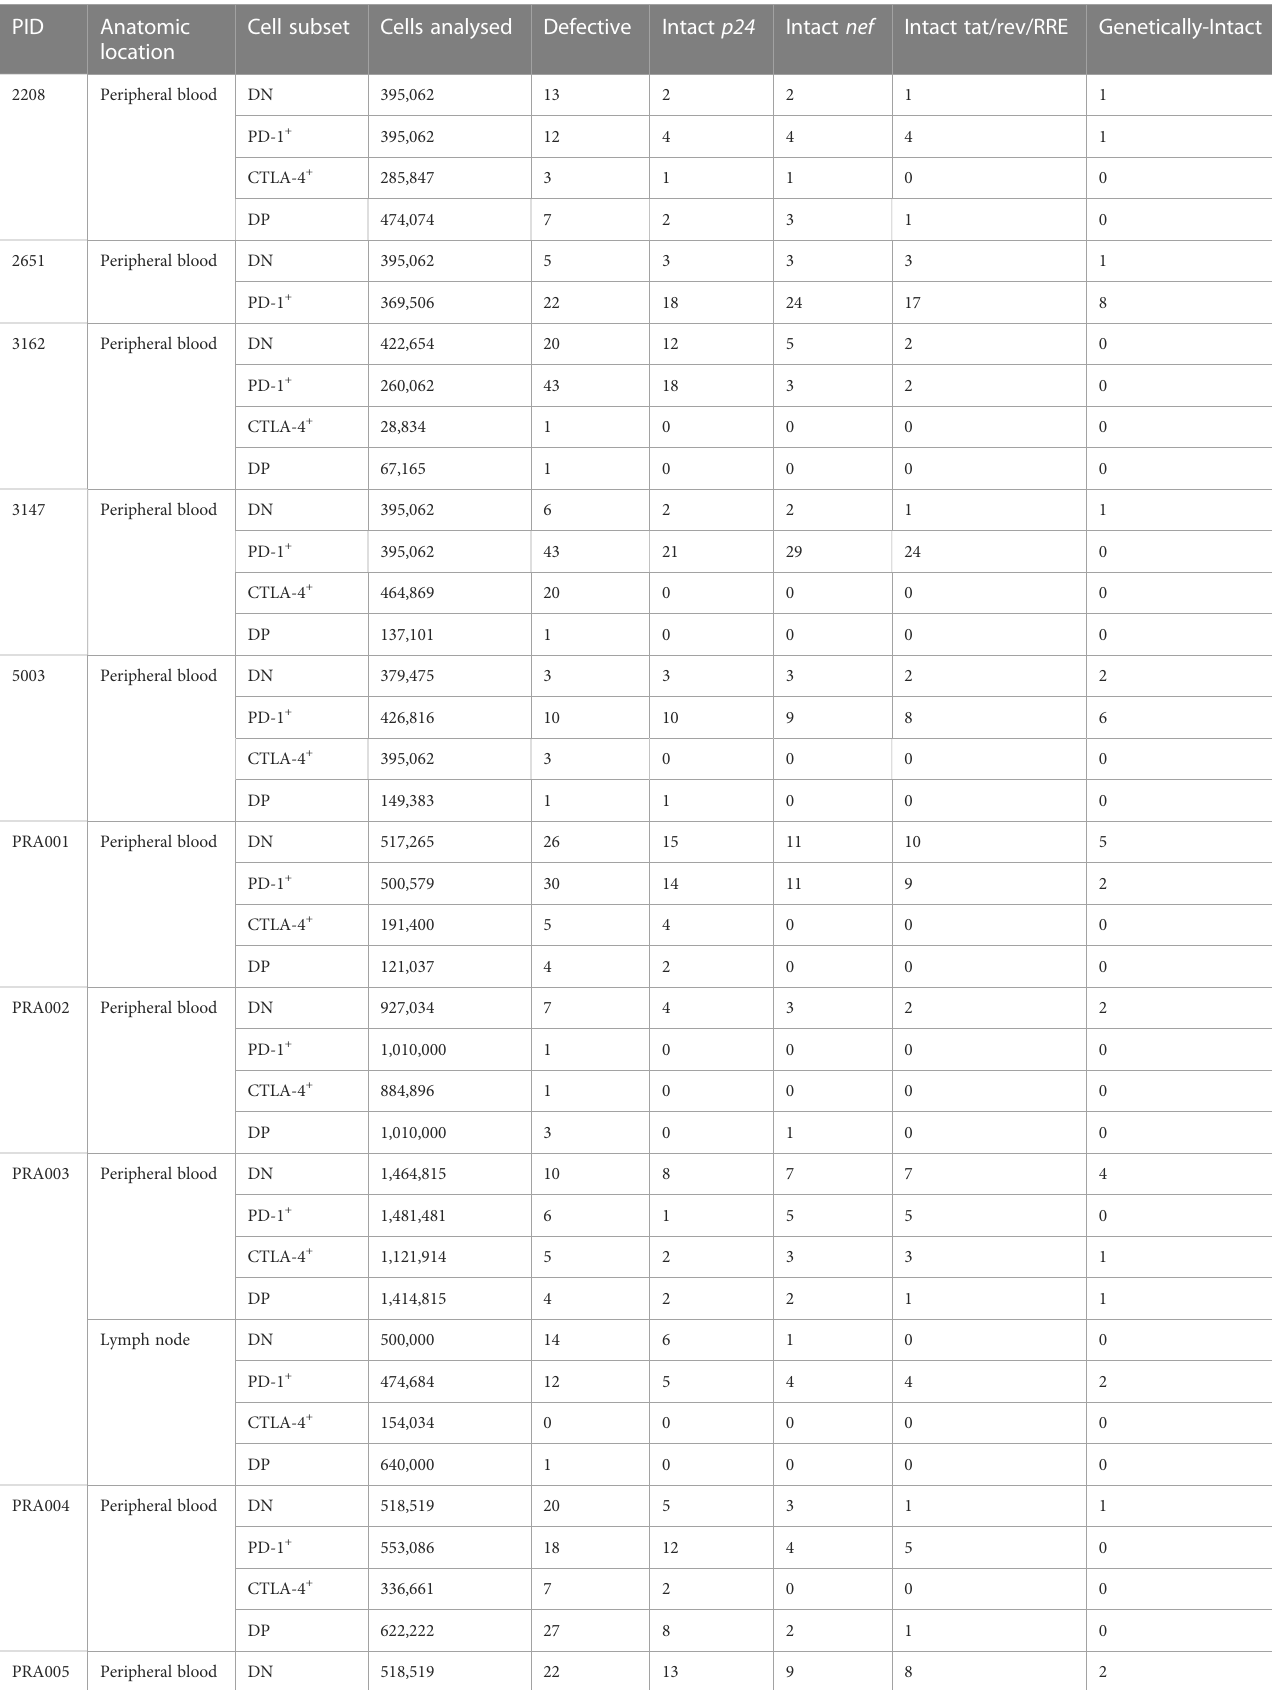
TABLE 2 Numbers and characteristics of proviruses ampli fi ed per cell subset and